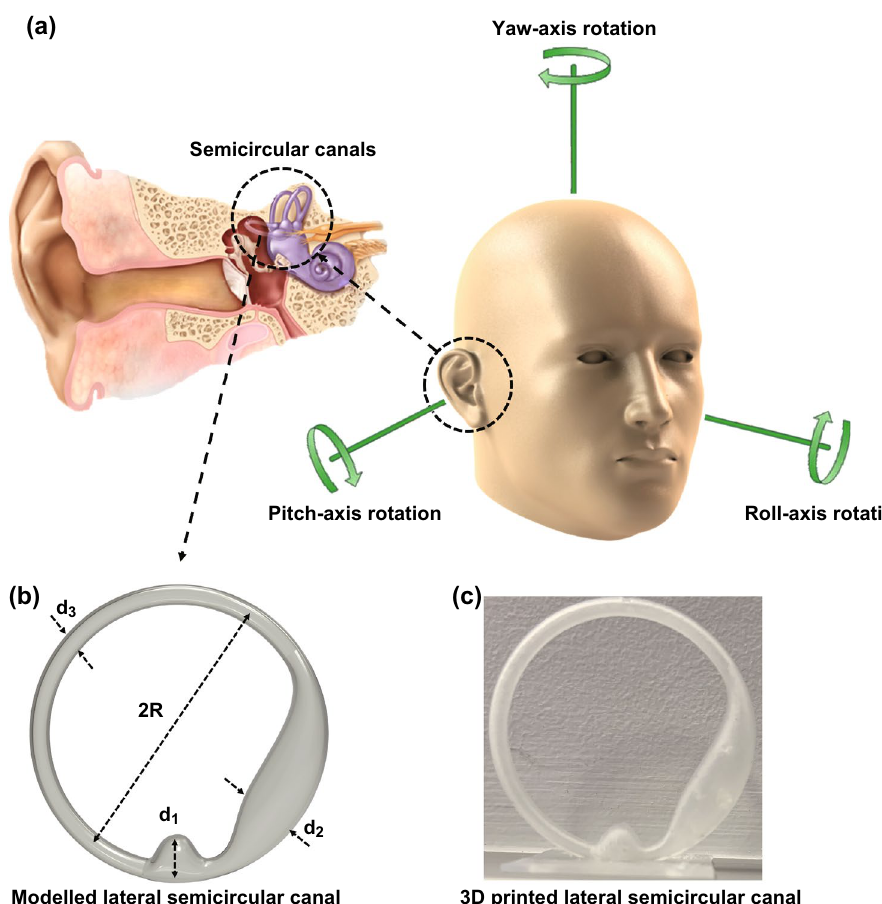
Fig. 5 a Magnified view of the inner ear and the rotational axis for head movement. b Modeled LSCC. c 3D printed